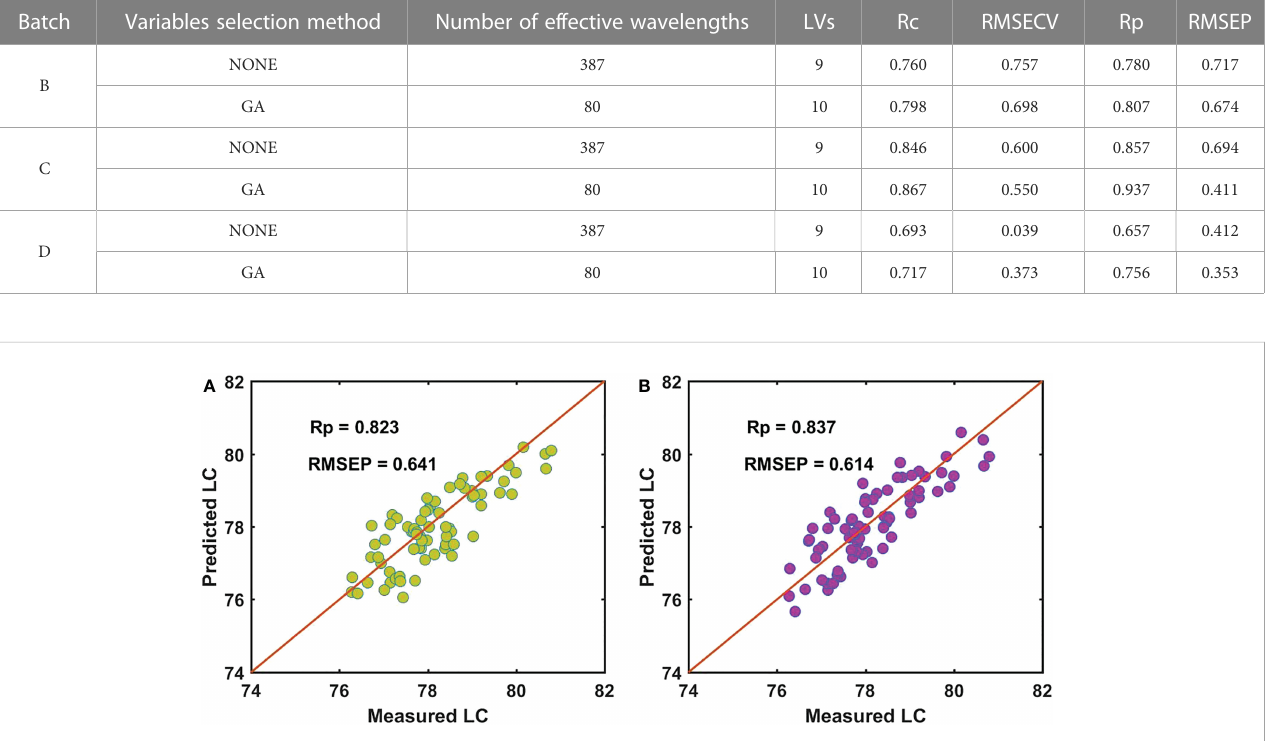
FIGURE 7 Performance for predicting LC of batch B of samples by (A) master model A and (B) Ind-model AB.